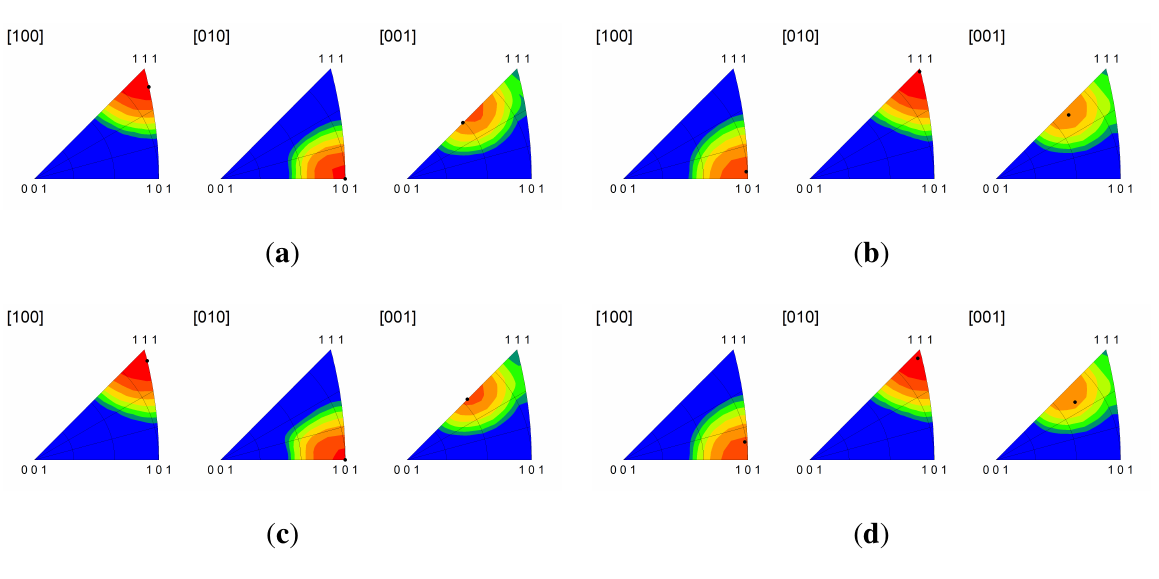
Figure 3. Combined inverse pole figures at 50% reduction from the multicrystal simulations for the ( a ) copper phase in the C-I interface; ( b ) niobium phase in the C-I interface; ( c ) copper phase in the D-I interface; and ( d ) niobium phase in the D-I interface. The final orientations obtained from the periodic bicrystal simulations are indicated by the filled black